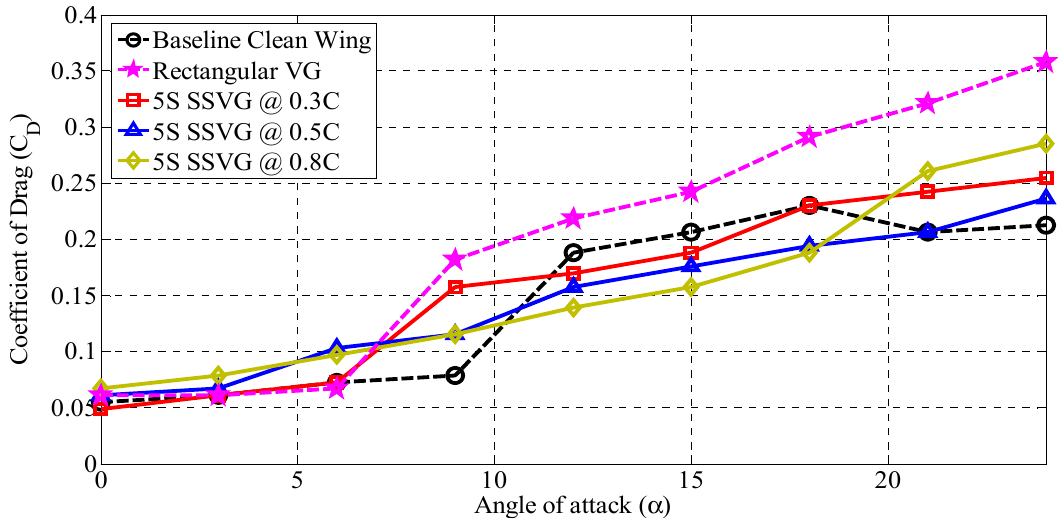
Figure 11. Coefficient of drag ( (cid:1829) (cid:3005) ) vs. angle of attack ( α ) for baseline and modified model with small sized (5S) SSVG.